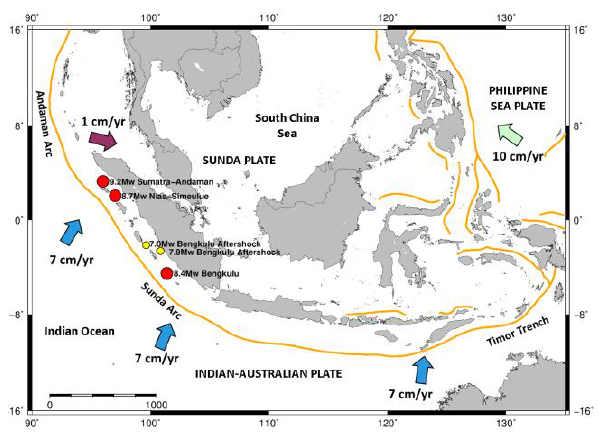
Figure 1. Three (3) major earthquakes and the aftershocks.